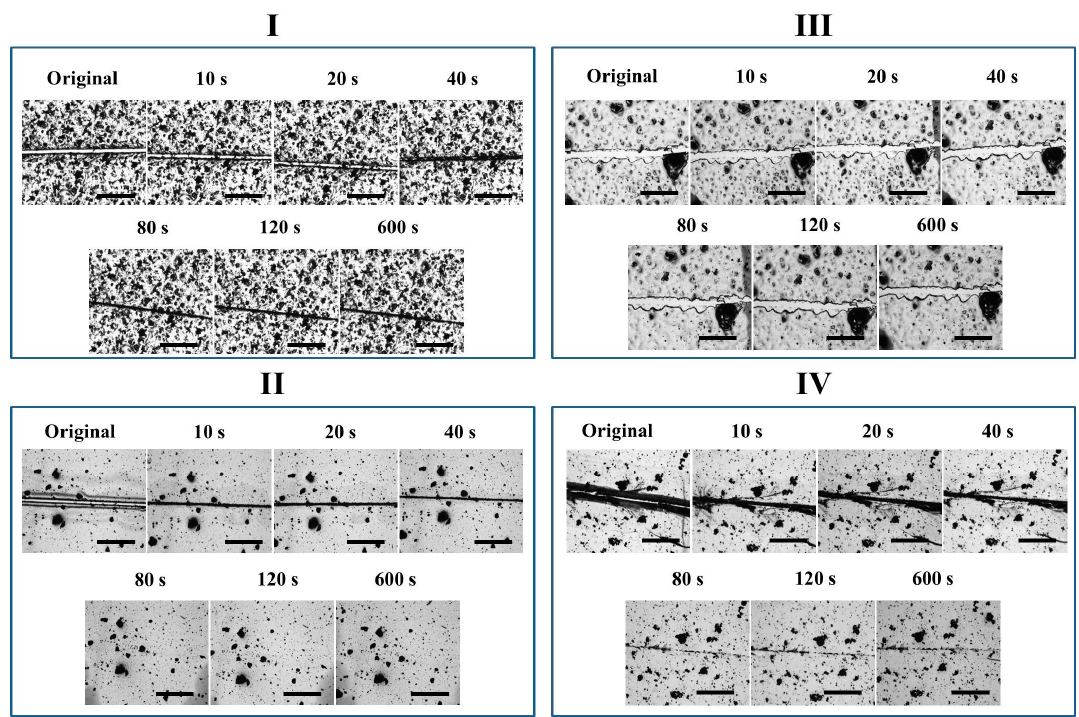
Figure 6. Optical images of how the cracks on the four coatings varied at 150 °C. The scale bar stands for 300 μ m. for 300 µ